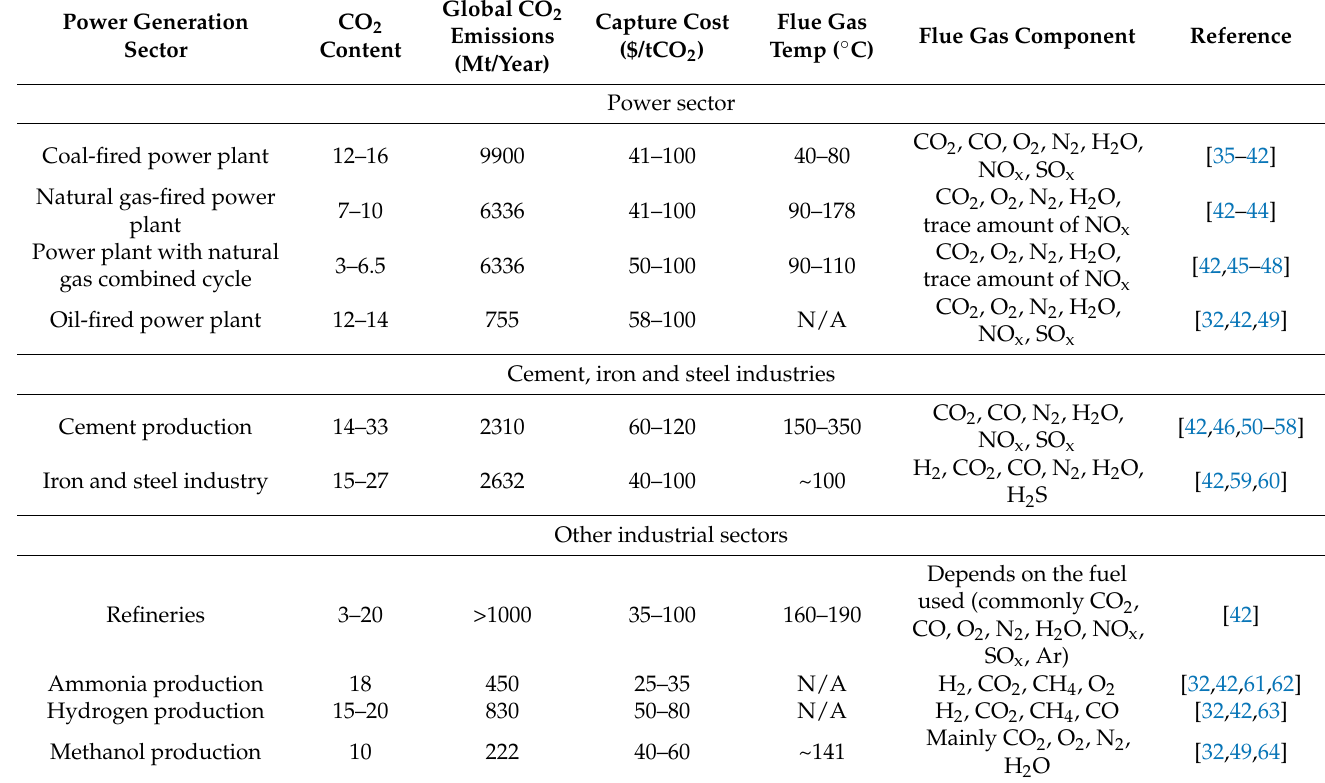
Table 1. Typical industrial sectors and stream characteristics. (modified from